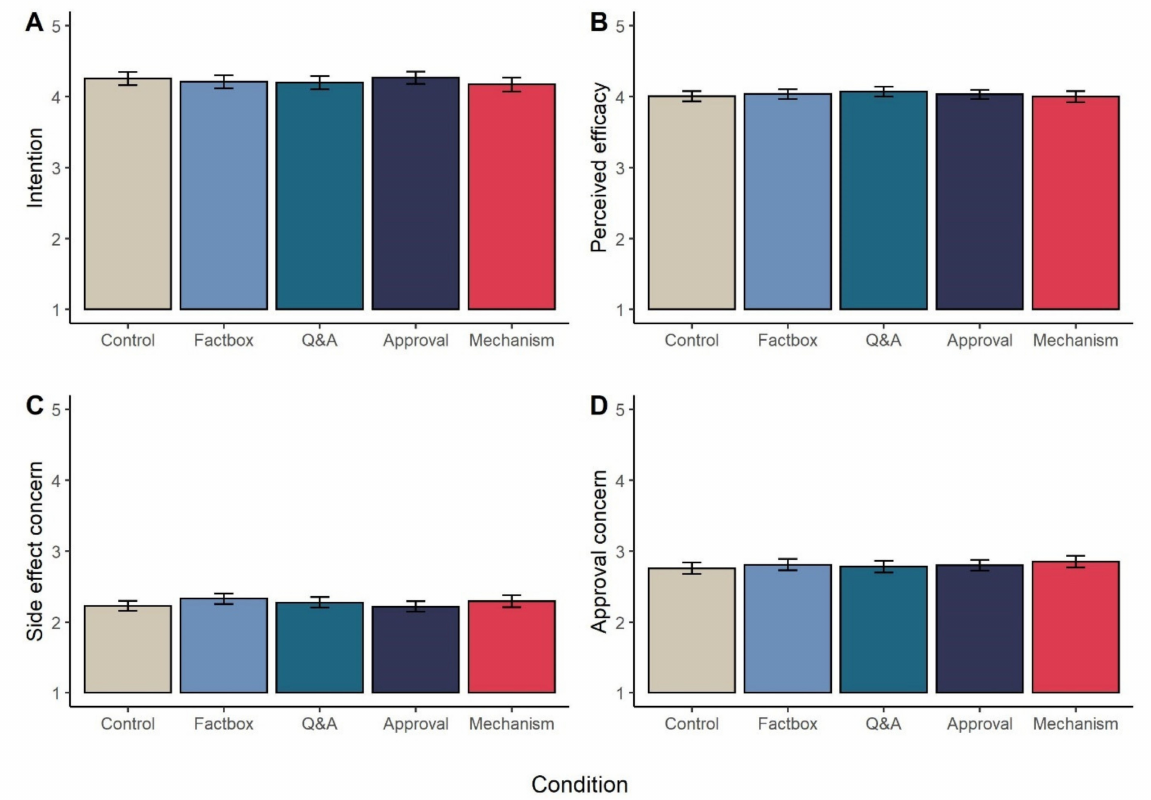
Figure 1. Mean levels (95% CI) of ( A ) intention to receive a COVID-19 vaccine, ( B ) perceived efficacy of COVID-19 vaccines, ( C ) concern over COVID-19 side effects, and ( D ) concern over speed of COVID-19 vaccine approval process, across the five experimental